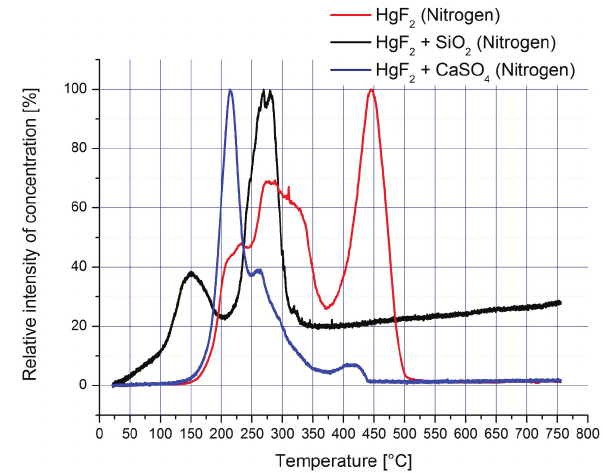
Figure 26: Thermograms of HgF